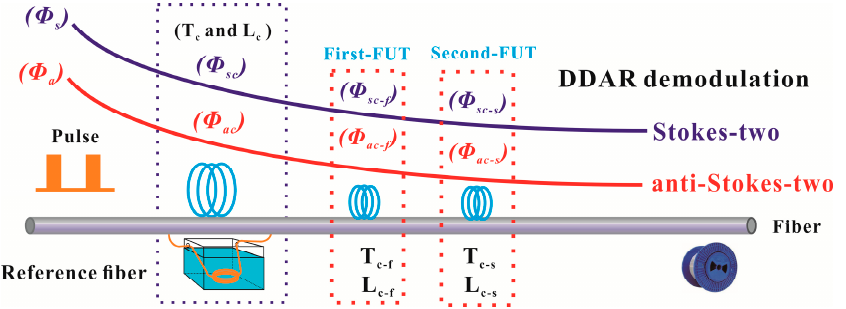
Figure 4. The dynamic difference attenuation recognition (DDAR) demodulation principle for DDP scheme.